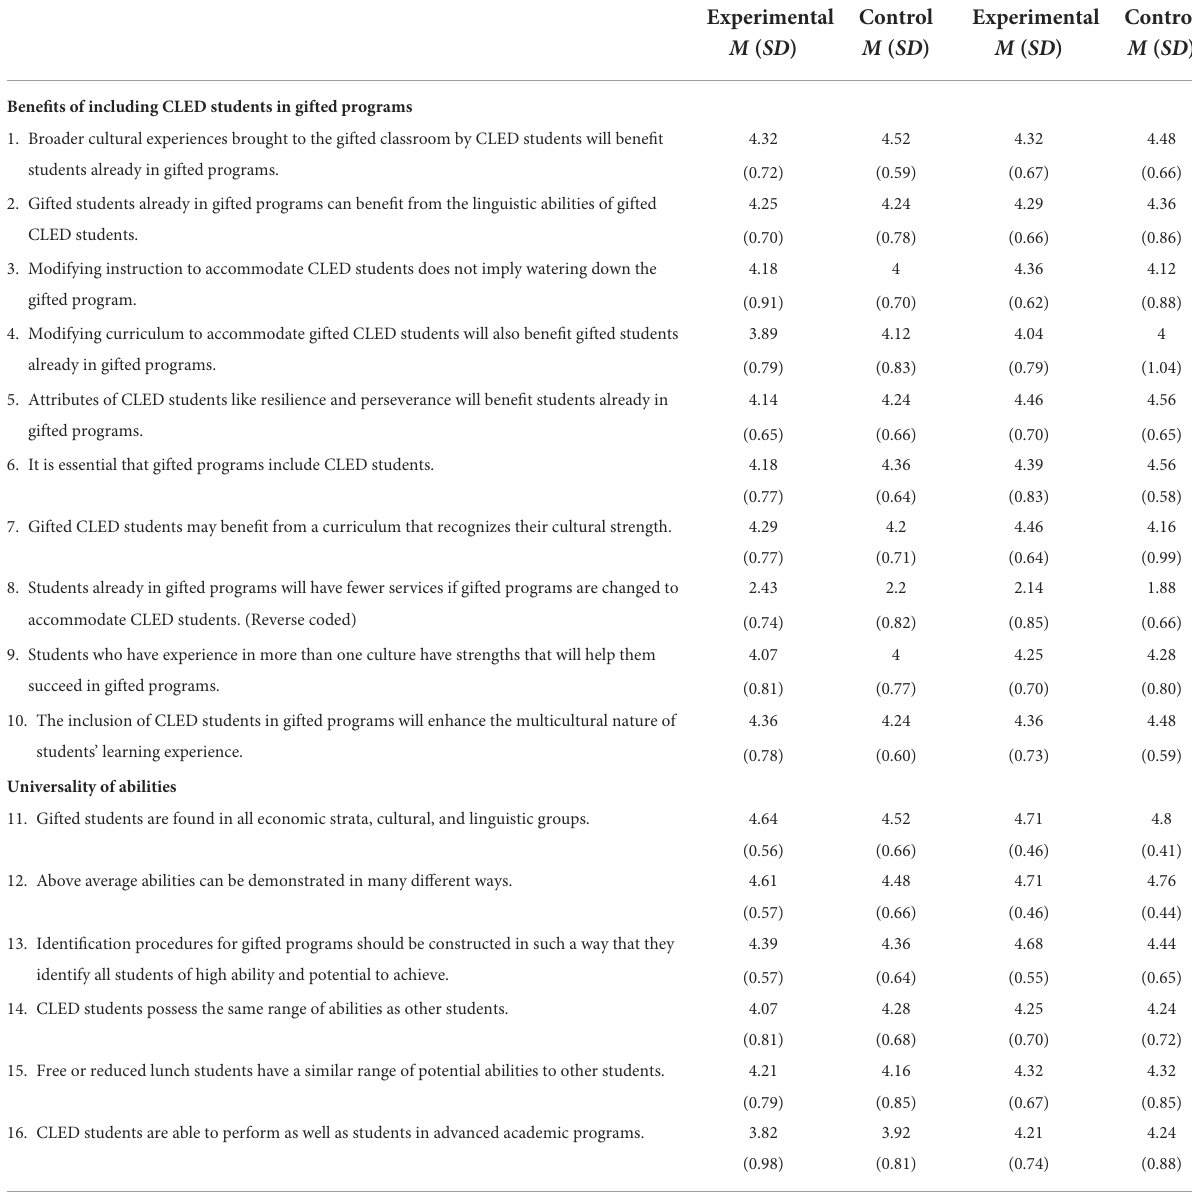
Pre Post Experimental